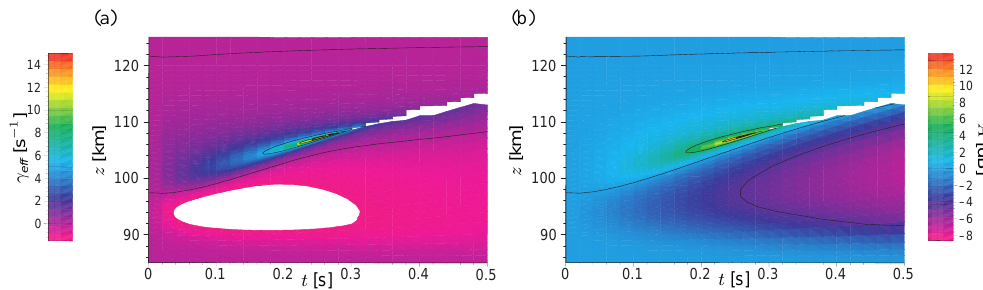
Fig. 7. Results for the same parameters as in Fig. 5 but with λ = 50 m instead of 12 m. Panel (a) : effective growth rate. Panel (b) : logarithm of amplitude.